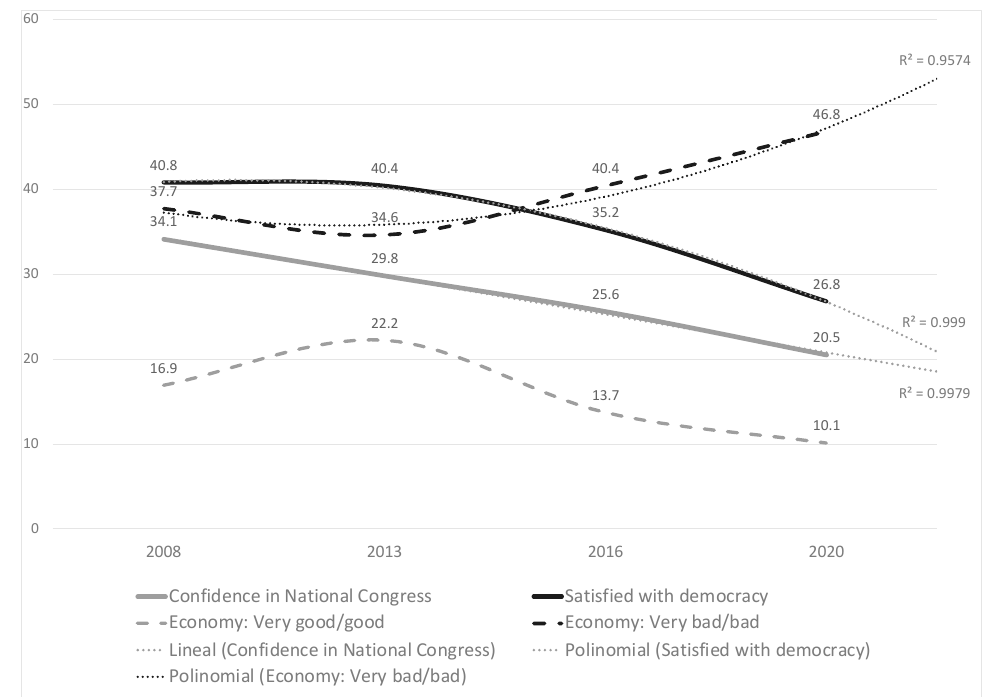
Figure 2. Trust in national congress and satisfaction with democracy 2008–2020. (Trend analysis using regression analysis). Source: Latinobarometer (2008–2020).